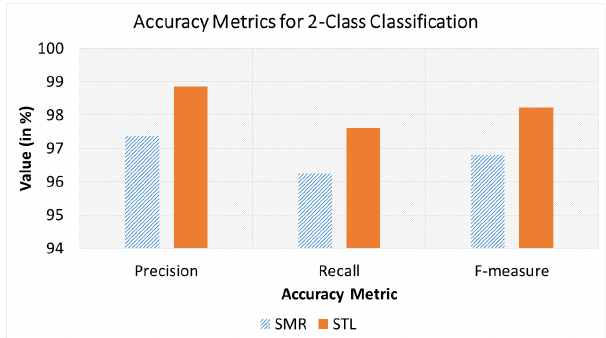
Figure 4: Precision, Recall, and F-Measure values using self-taught learning (STL) and soft-max re- gression (SMR) for 2-Class when applied to training data